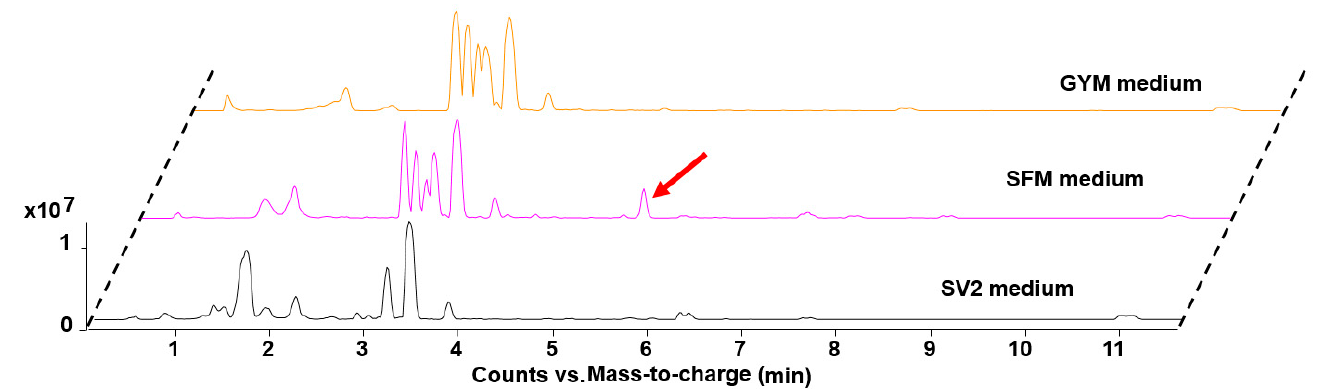
Figure 2. Comparison of metabolite profiles of the A. spheciospongiae fermented in SFM, GYM, and SV2 medium, respec- tively.